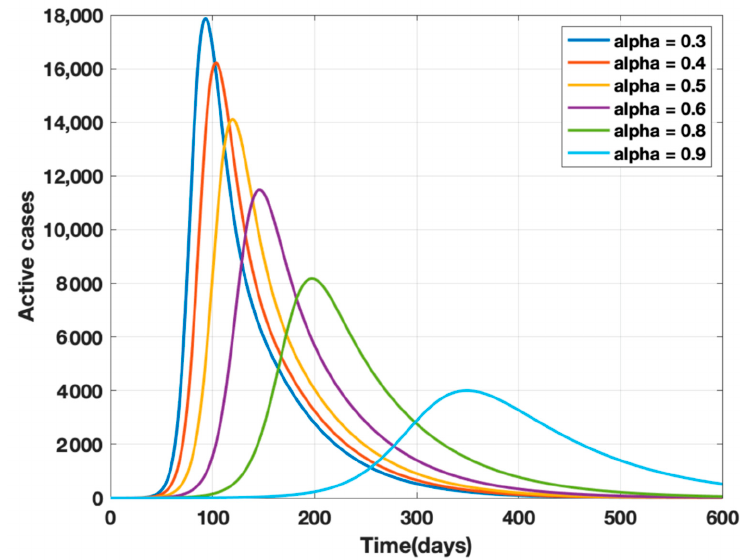
Figure 2. Sensitivity analysis of α and k for α = 0.3, 0.4, 0.5, 0.6, 0.7, 0.8, and k = 10, ρ − 1 = 10 days.